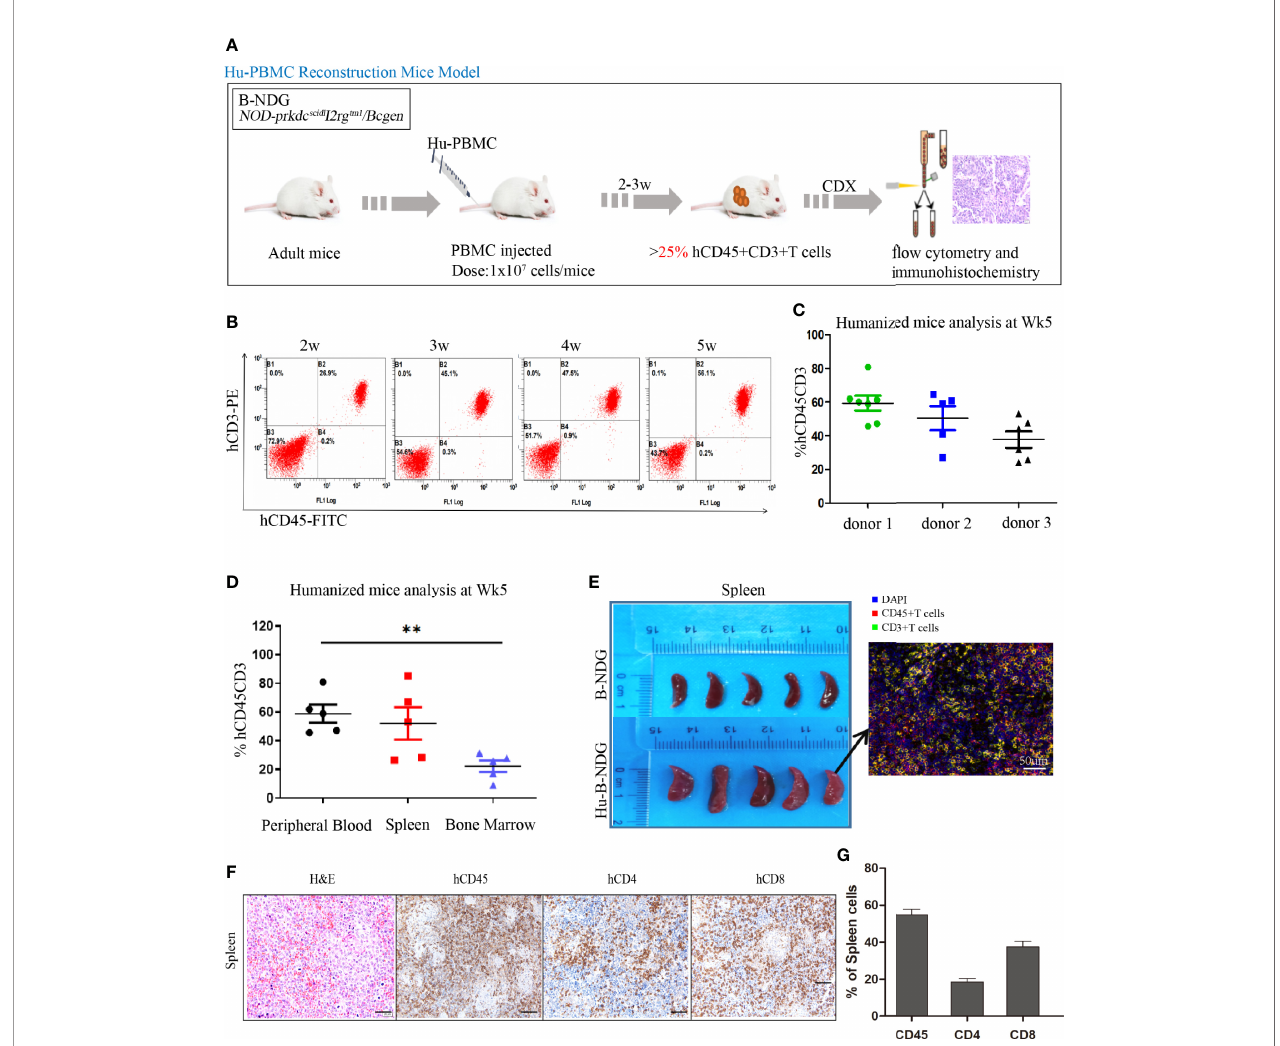
FIGURE 2 | Construction and identi fi cation of humanized mouse model of immune system. (A) Adult B-NDG mice were injected with 1 × 10 7 PBMC (iv), followed by subcutaneous injection of 5 × 10 6 tumor cell lines. 2-3 weeks later, the peripheral blood of mice was collected from the tail vein to detect the content of hCD45+CD8+T cells, which marked the successful construction of the Hu-PBMC-CDX mouse model when it was more than 25%. (B) Dynamic fl ow detection of hCD45+CD3+T cell level in peripheral blood of a representative Hu-PBMC mouse model. (C) Reconstruction level of humanized mice constructed by PBMC from three different donors at the fi fth week, n=5. (D) Reconstruction levels of hCD45+CD3+ T cells in peripheral blood, spleen and bone marrow of humanized mice at the 5th week, n=5. **P<0.01. (E) The spleen of normal B-NDG mice was compared with that of Hu-PBMC mouse model mice, n=5. (F, G) Immunohistochemistry for CD45, CD8, CD4, and H&E stains in spleen are shown. Representative images were taken at 20x magni fi cation and the scale bar denotes 50